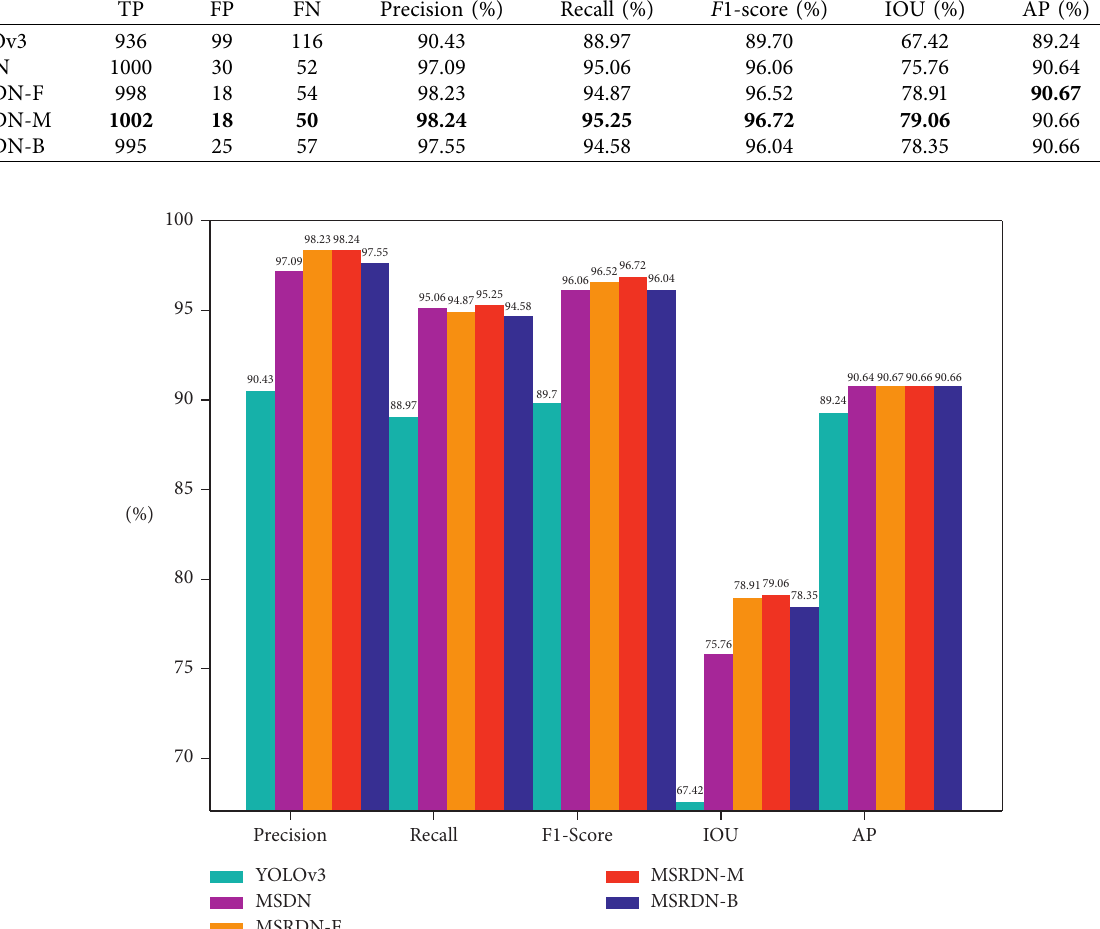
Figure 16: The comparison of performance